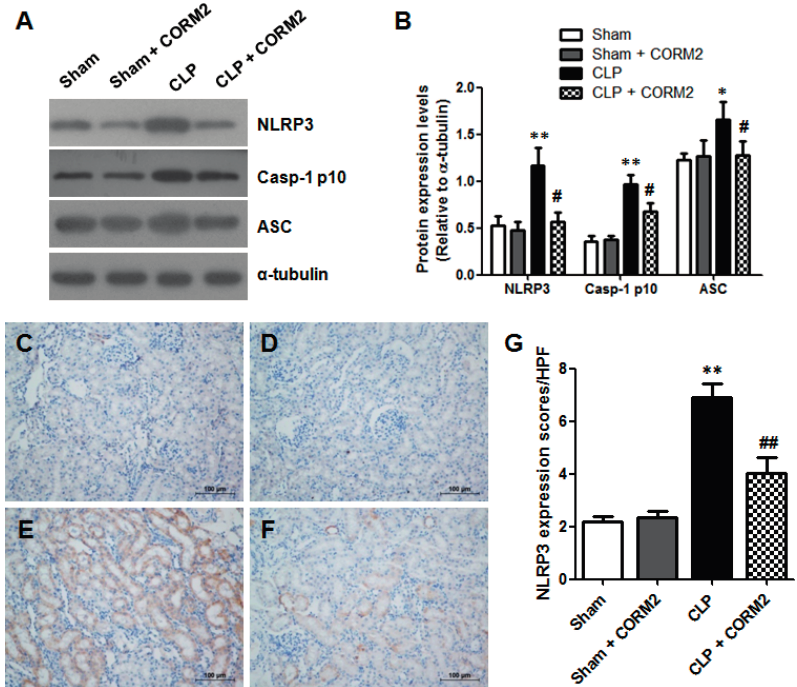
Figure 6. Carbon monoxide decreased NLRP3 inflammasome activation in renal tissues of septic rats. ( A ) NLRP3, Caspase-1 p10 (Casp-1 p10) and ASC protein expressions in renal tissues were determined by western blot. α -tubulin was measured as the loading control; ( B ) Quantification of the protein expressions by measuring bands intensity in western blot. CLP-induced sepsis lead to increase of NLRP3 and Caspase-1 p10 expressions in renal tissues, but CORM-2 treatment decreased NLRP3 and Caspase-1 p10 expressions in CLP-induced renal tissues. CORM-2 had no effect on NLRP3 inflammasome activation in renal tissues to normal rats (Sham). Results are presented as mean ± SD, n = 3 rats per group. * p < 0.05, ** p < 0.01 vs. sham group and # p < 0.05 vs. CLP group; ( C – F ) The NLRP3 expression was evaluated in renal tissues by immunohistochemical staining; ( C ) Sham group; ( D ) Sham + CORM-2 group; ( E ) CLP group; ( F ) CLP + CORM-2 group. Scale bar = 100 μ m; ( G ) Semi-quantitative the NLRP3 expression (brown cells in C – F ) in renal tissues of septic rats. CLP-induced sepsis lead to increase of NLRP3 expression in renal tissues, but CORM-2 treatment decreased NLRP3 expression in CLP-induced renal tissues. CORM-2 had no effect on NLRP3 expression in renal tissues to normal rats (Sham). Results are presented as mean ± SD, n = 6 rats per group. ** p < 0.01 vs. sham group and ## p < 0.01 vs. CLP